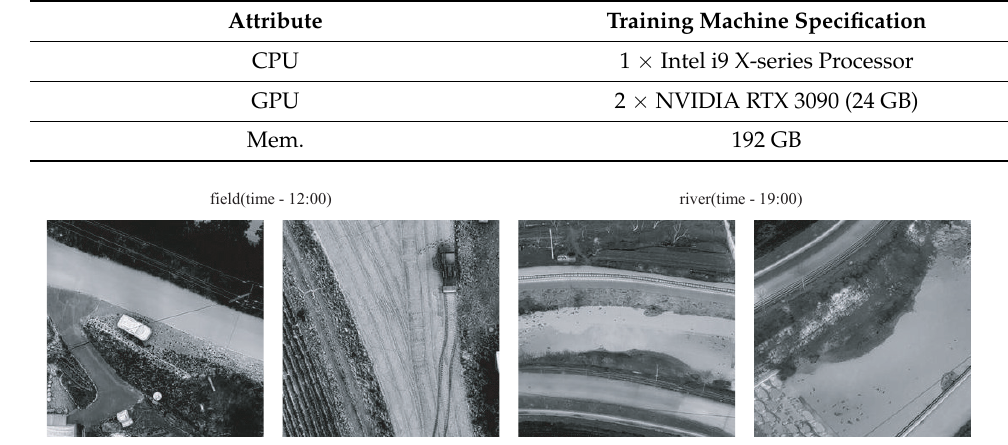
Figure 4. Real IR images taken with a drone system with IR camera (ZENMUSE H20T): the left two images were taken in the field at 12:00, and the right two images were taken around small stream at 19:00.